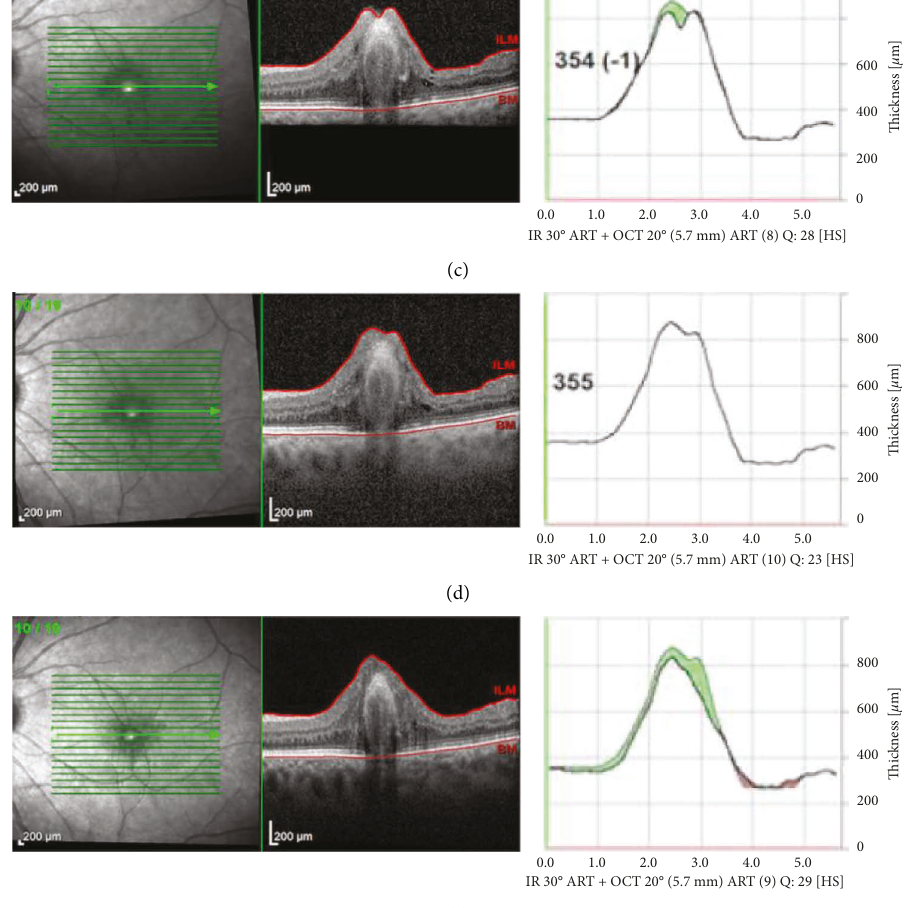
Figure 2: Foveal architecture changes in a patient with hyperproliferation. SD-OCT: (a) 1 month postoperatively; (b) 3 months post- operatively; (c) 6 months postoperatively; (d) 9 months postoperatively; (e) 1 year